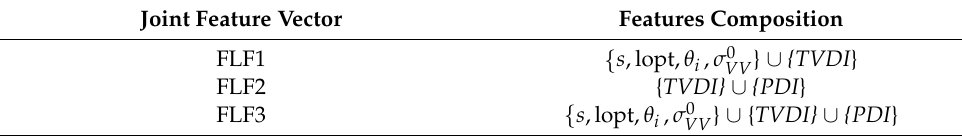
Table 1. Feature level fusion joint